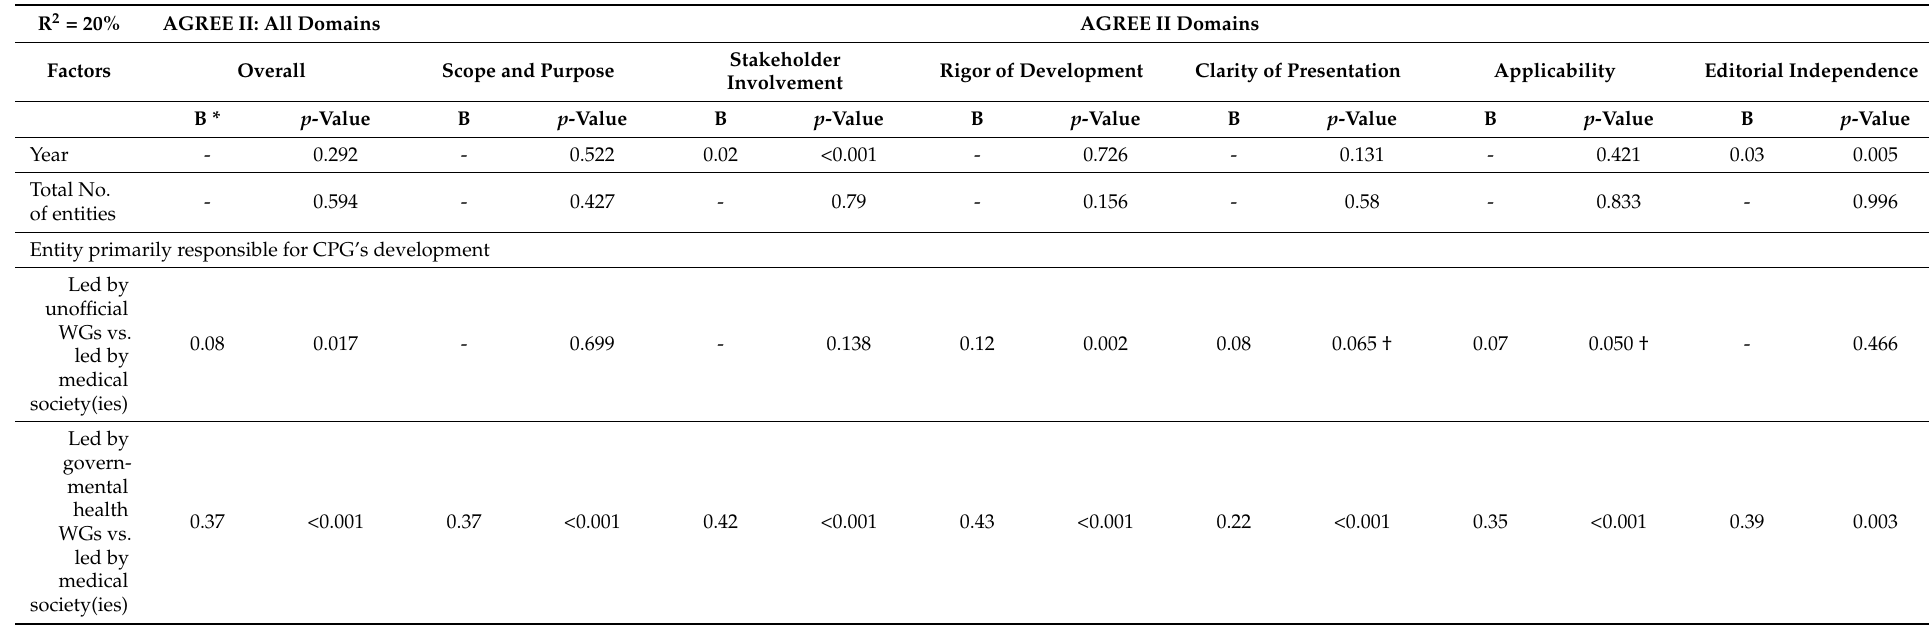
Table 1. Effects of different factors on quality of Croatian guidelines, shown by AGREE II